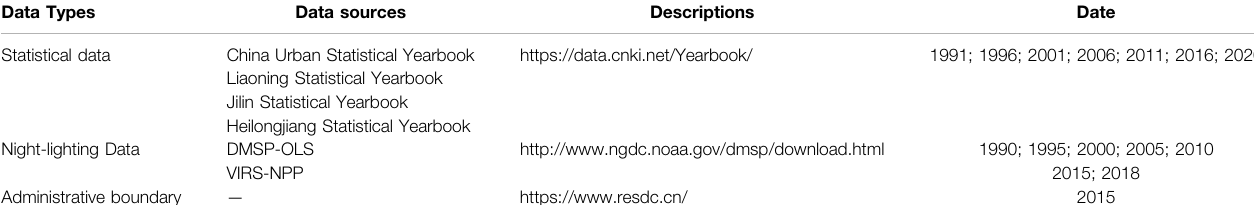
TABLE 2 | Data sources and descriptions.